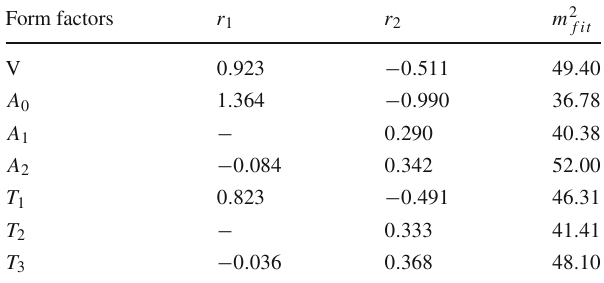
Table 6 Form factors for B → K ∗ l 1 l 2